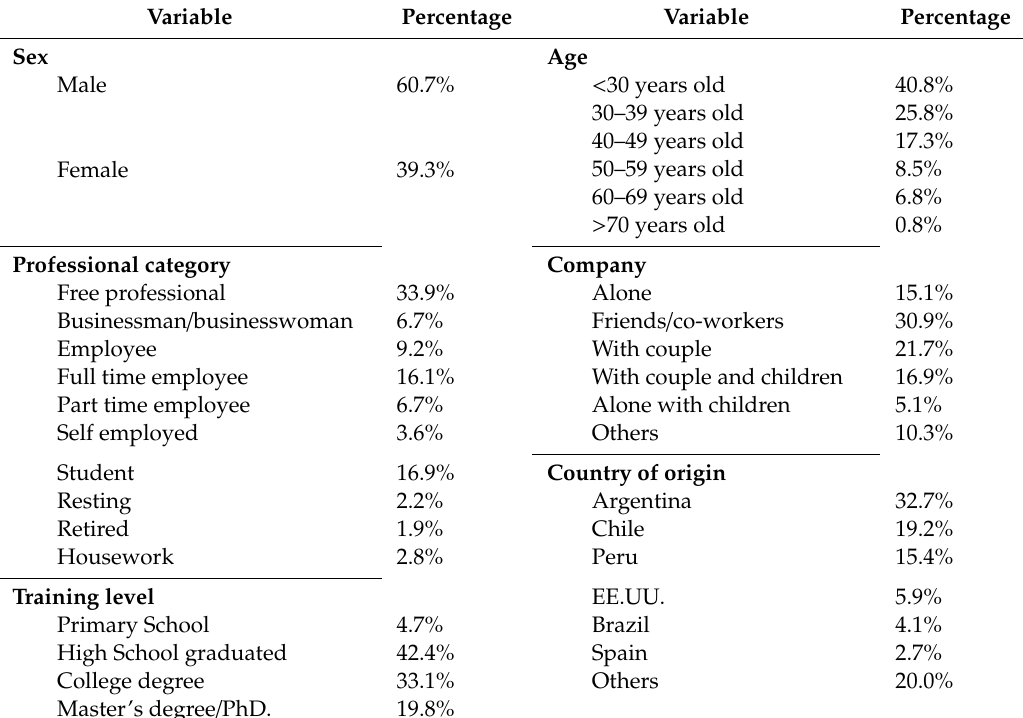
Table 1. Sociodemographic